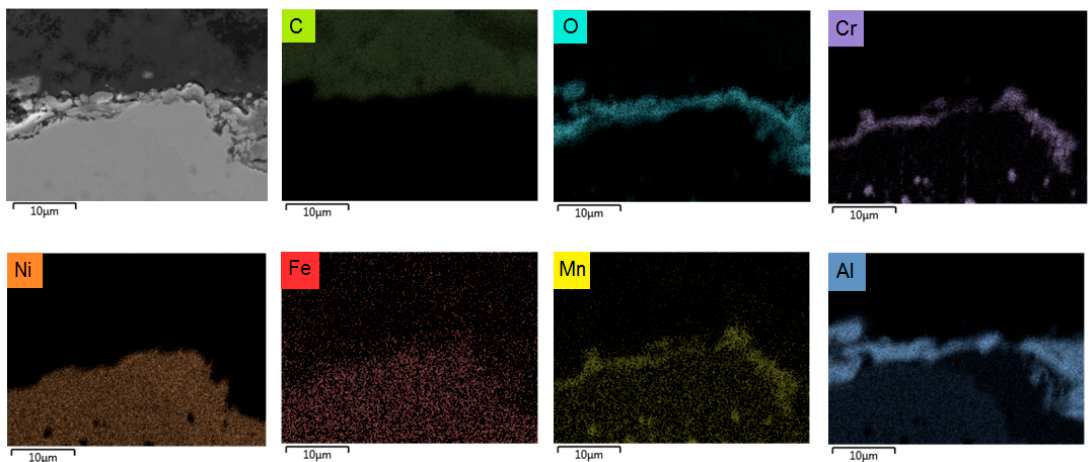
Figure 9. Cross-sectional elemental mappings of a CoatAlloy ™ sample after application of the standard pretreatment. Magnification: 3000 × , accelerating voltage: 15 kV.